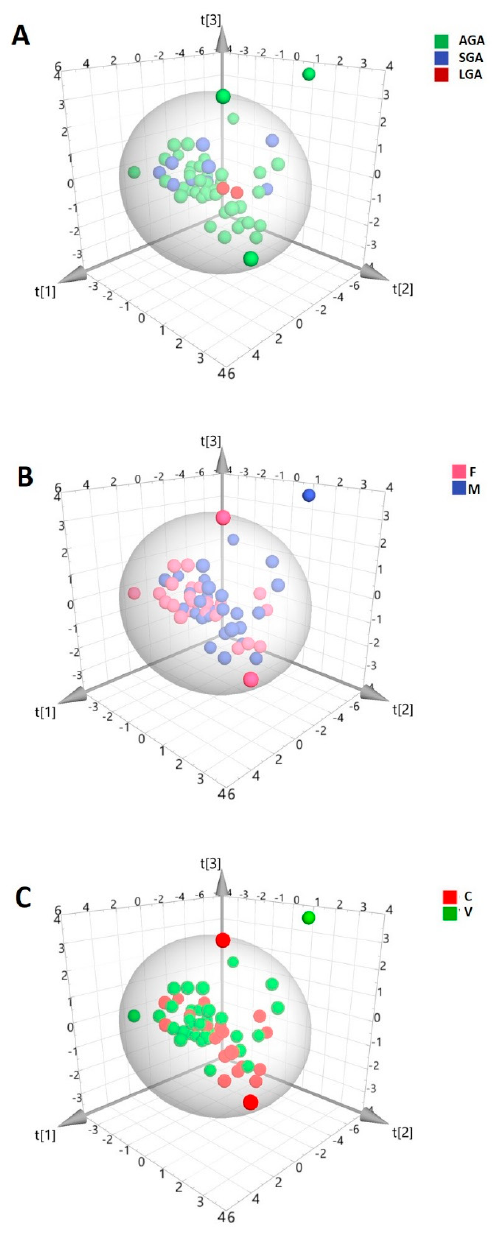
Figure 2. Three-dimensional (3D) principal components analysis (PCA) score plot of the overall data set of human breast milk (HBM) spectra from 1 H-NMR. (PC1 = 37.8%; PC2 = 17.2%; PC3 = 13.1%). The scores are colored according to ( A ) neonatal customized centiles (AGA: appropriate for gestational age; LGA: large for gestational age; SGA: small for gestational age); ( B ) gender (F: female; M: male); ( C ) mode of delivery (C: cesarian; V: vaginal).